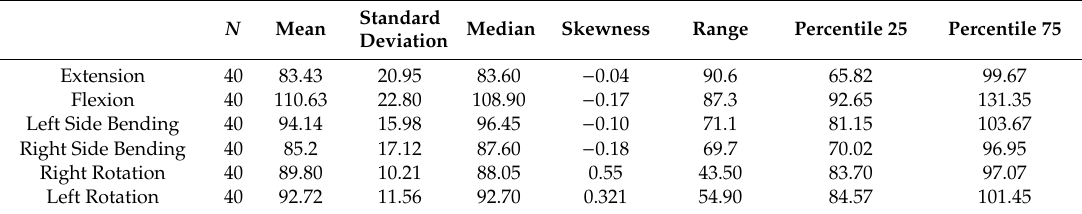
Table 3. Control group normalized values of ROM using the AMA guidelines.